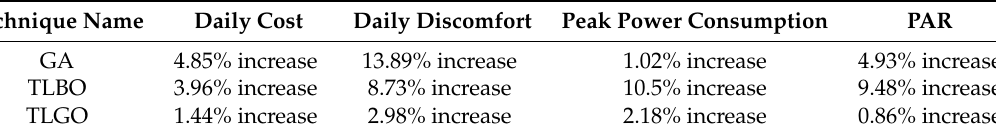
Table 4. Comparison of GA, TLBO and TLGO with LP under DAP for 1 h time slot.